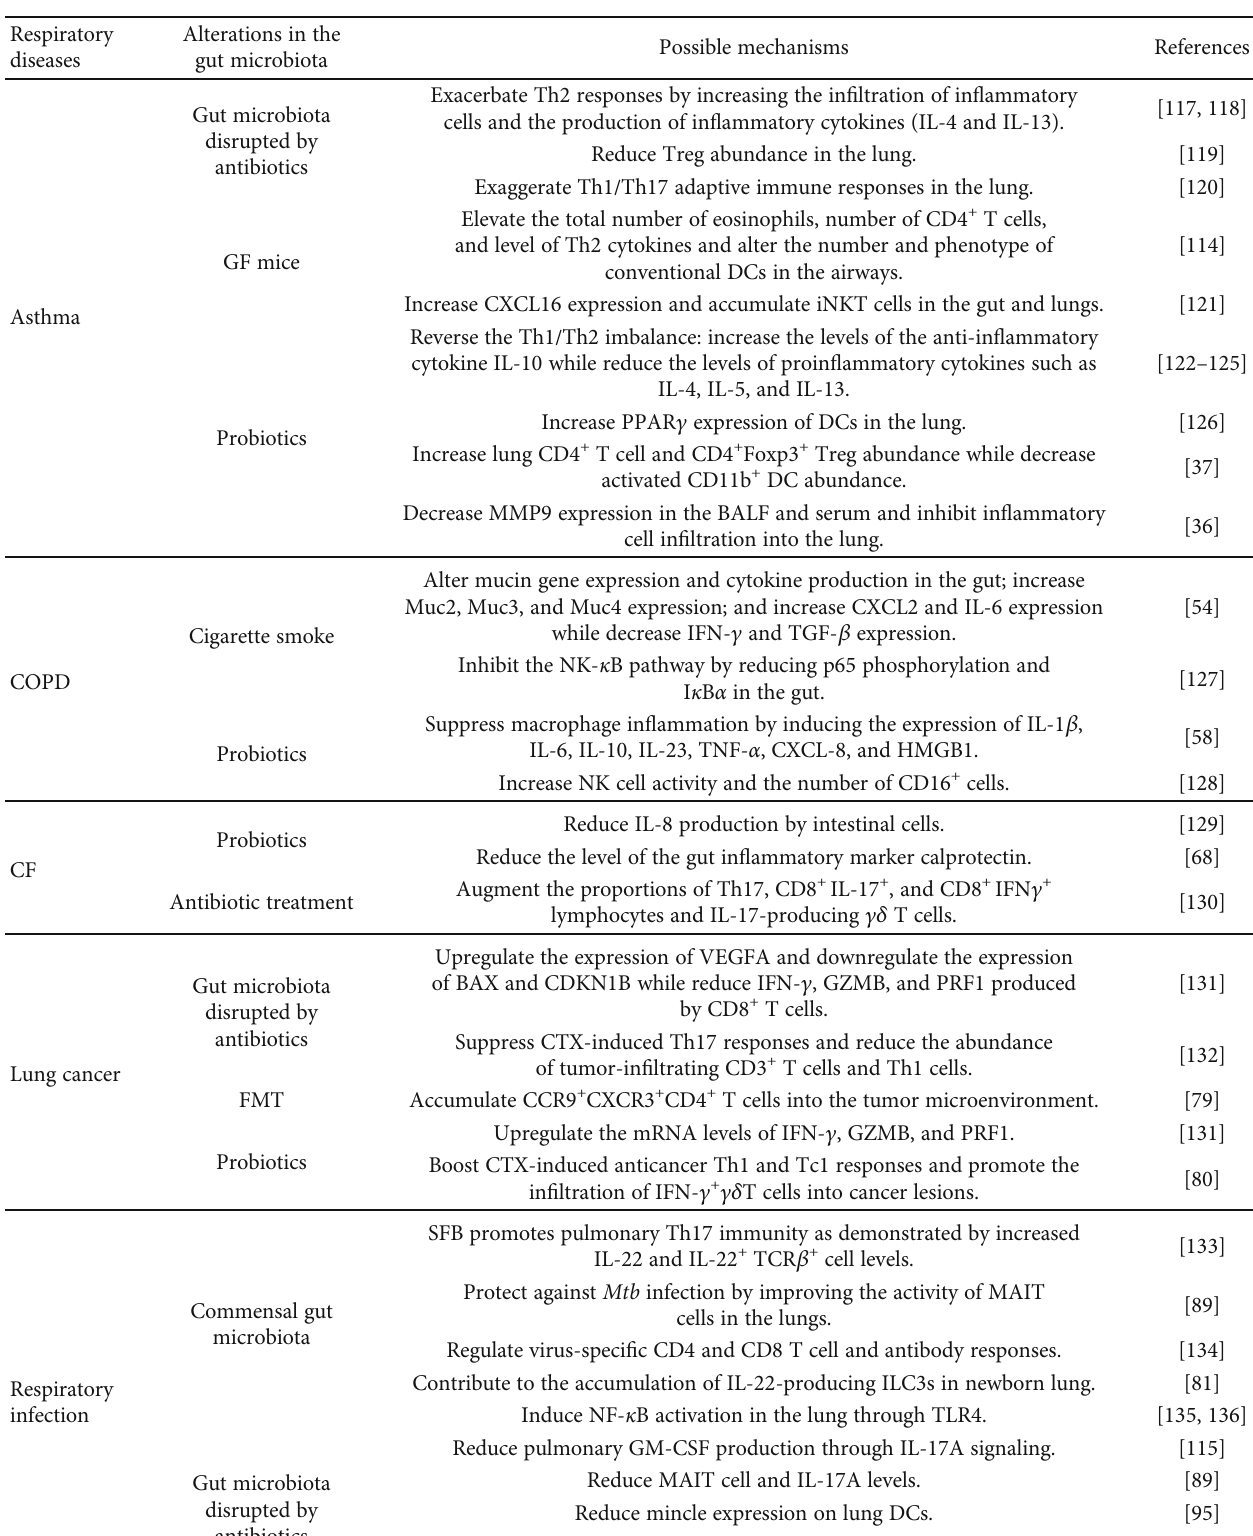
Table 1: The possible mechanisms underlying the e ff ects of the gut microbiota on respiratory diseases. Respiratory